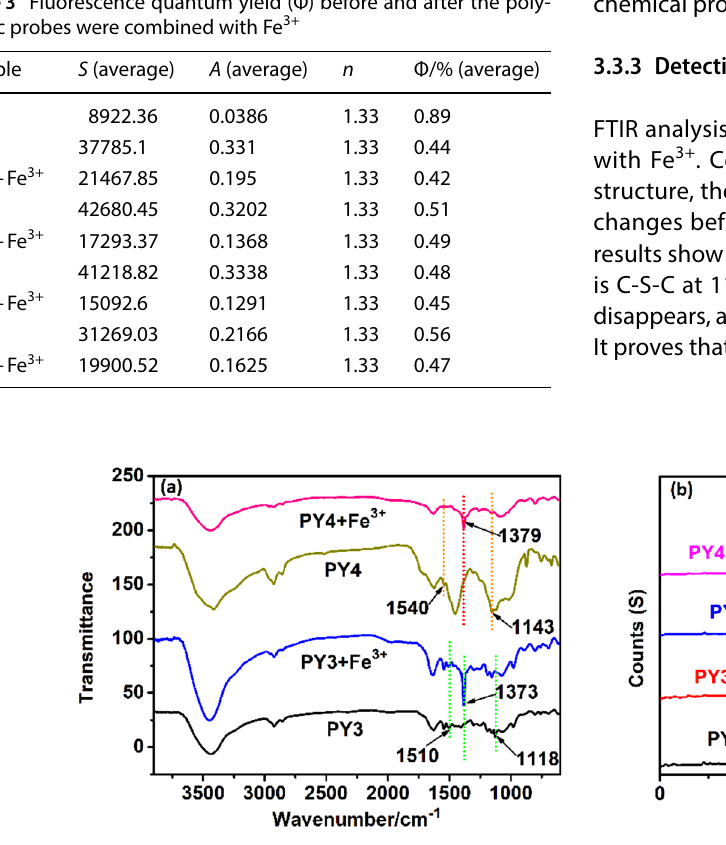
Fig. 7 a FTIR spectrum of PY3 and PY4 with equimolar amount of Fe 3+ , and b XPS spectrum of PY3 and PY4 with Fe